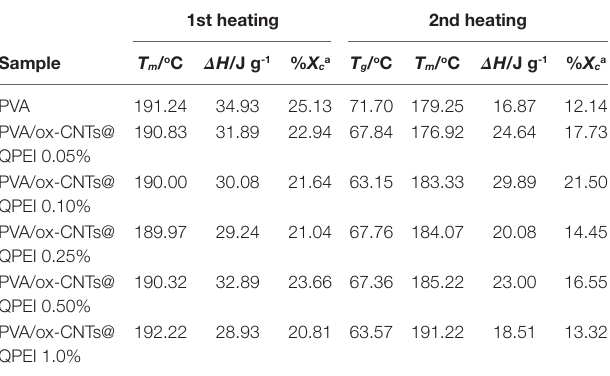
Table 1 | Melting temperature ( T m ), glass transition temperature ( T g ), enthalpy (